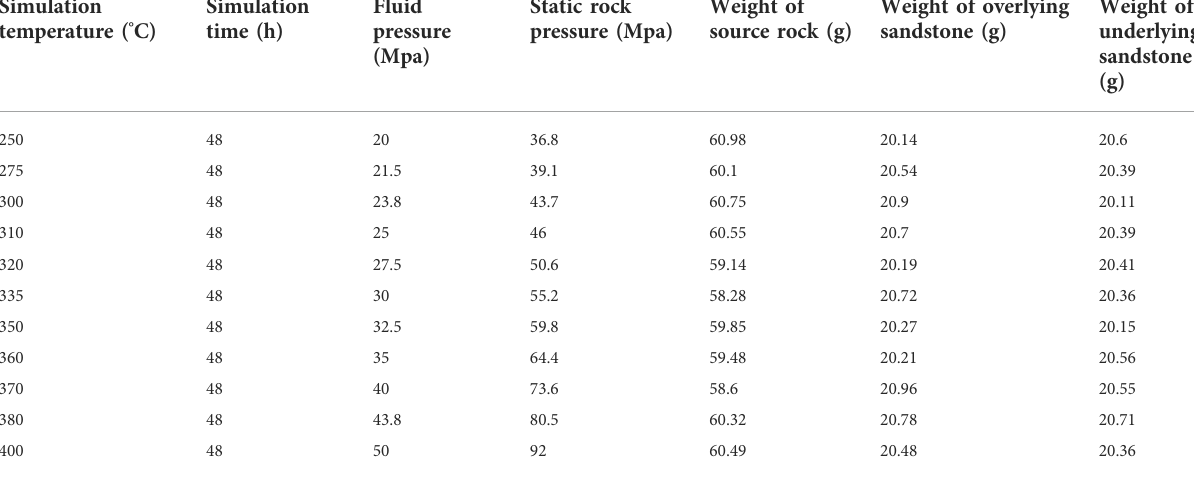
TABLE 1 Hydrocarbon generation and expulsion experiment program of source rock sample HX4 in the Jinhu Sag, Subei